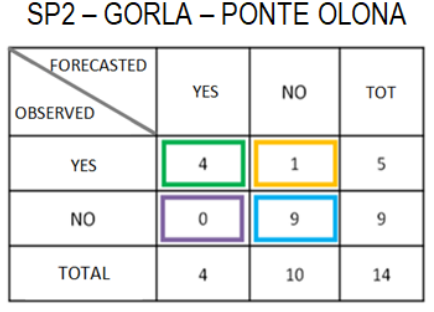
Figure 10. Contingency tables for cloudy days. Table 12. Evaluation of algorithm performance for the ice alert code forecast for Pedemontana motorway: values assumed by the indices.